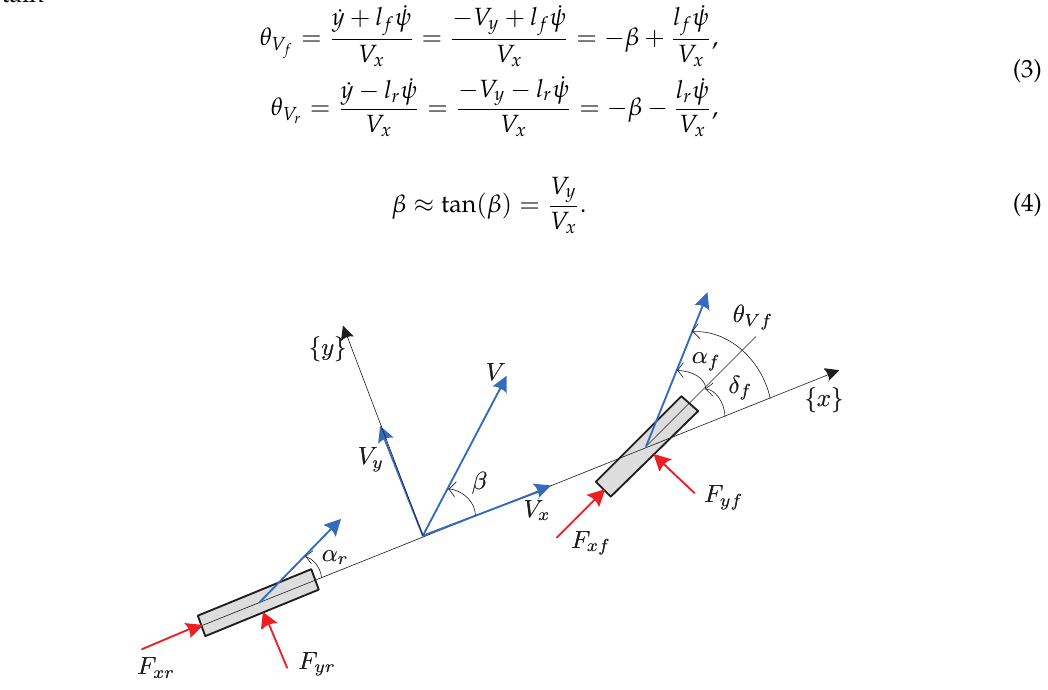
Figure 2. Bicycle model of the vehicle for lateral